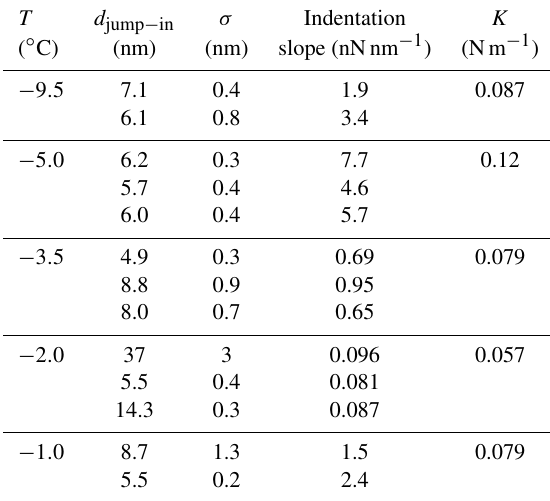
Table 1. Average jump-in distances ( d jump − in ) obtained from AFM force curves over ice with the EC using silicon tips. The dispersion ( σ) obtained for various repeated measurements and the indenta- tion slopes corresponding to the first 50nm are also reported. Dif- ferent rows at the same temperature correspond to different ( x,y ) positions on the ice sample. The spring constants for the cantilevers measured at ambient temperature are also informed.